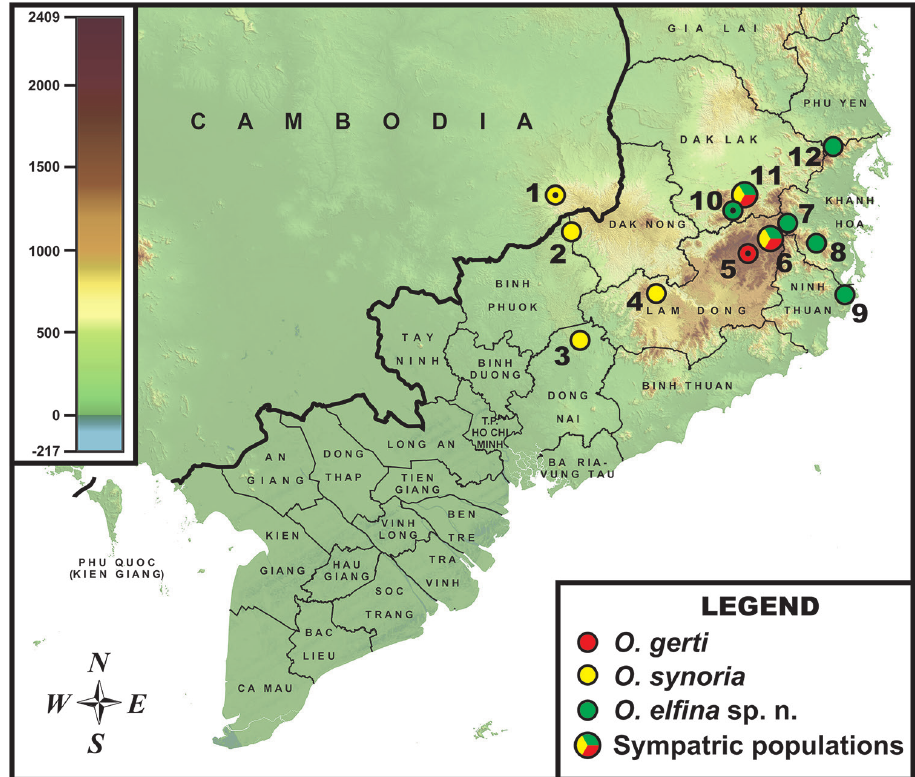
Figure 1. Distribution of Ophryophryne species in southern Indochina (Langbian Plateau in Vietnam, and adjacent regions of Camodia), indicating localities sampled in this study. Black dot in the center of an icon indicates the type locality of the new species. Locality information. 1 O Chung Chry stream, Sam- ling Logging Concession, O’Rang Dist., Mondolkiri Prov., Cambodia (500 m a.s.l.) (Stuart et al.